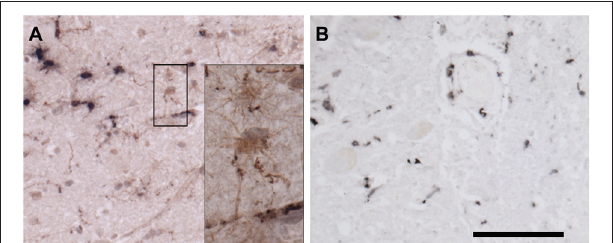
FIGURE 6 | Immunohistochemical staining for microglia. (A) Frontal cortex stained for Iba-1 (brown) and CD68 (black). Most microglia in this field contain large deposits of CD68 immunoreactivity and shirt, thick processes, indicating activation. By contrast, occasional surveilling microglia, are also present. The black box surrounds two such cells, whose somas and long, fine processes are apparent in the inset. (B) Spinal cord stained for CD163. CD163 is expressed by resident perivascular macrophages, which are normally present, but also by macrophages derived from circulating monocytes. Bar = 100 microns for (A,B) . Inset is photographed at three times greater magnification in a stack spanning the thickness of the tissue at 0.25-micron intervals. The “Deep Focus” feature of Neurolucida 360 (MBF Bioscience) was used to combine the best focused objects from each layer of the stack into a single layer.